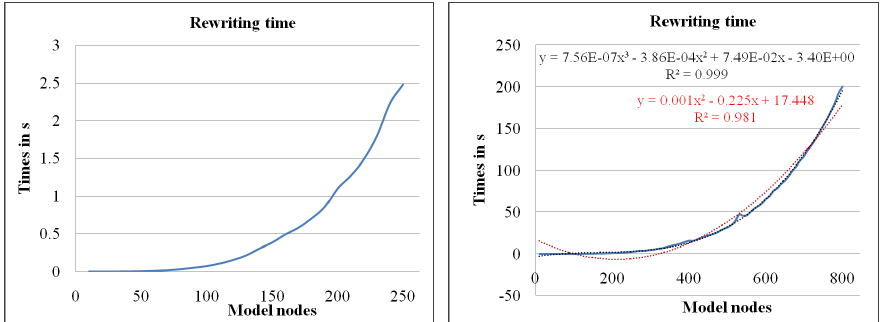
Figure 11. Analysis of the model